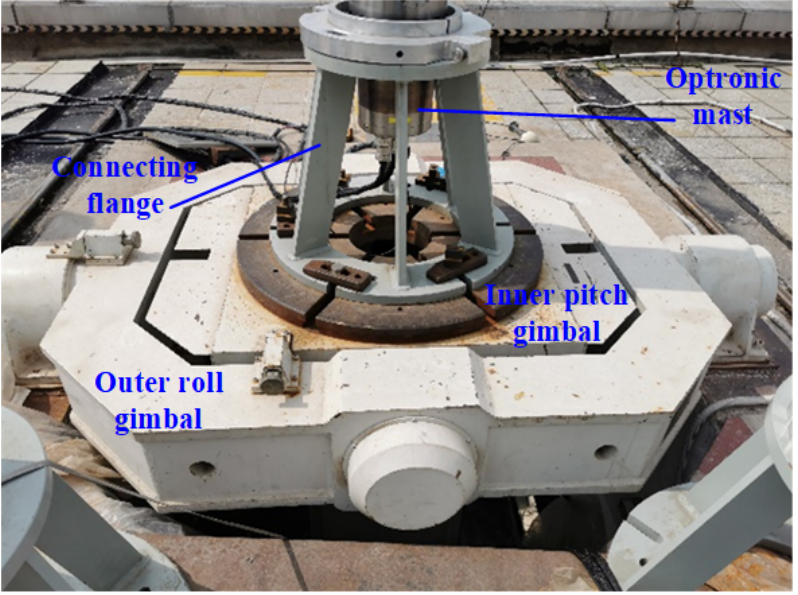
Figure 8. The swaying test platform experiment